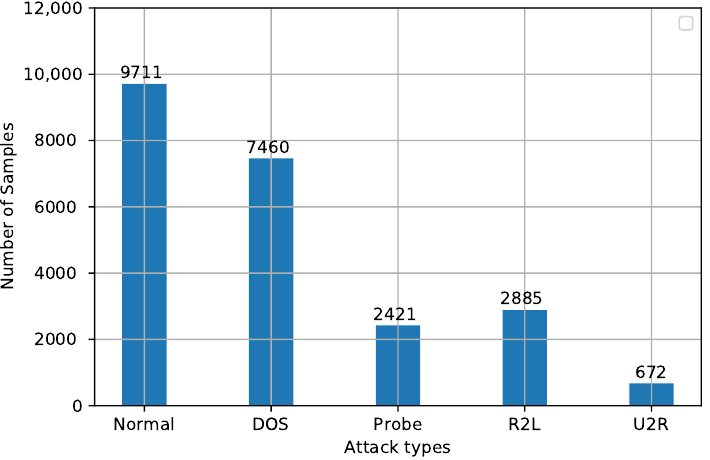
Figure 4. Categorized test set statistics show the number of samples in the four types of attacks and the normal samples in the test set. These samples are an unseen set, for model evaluation.